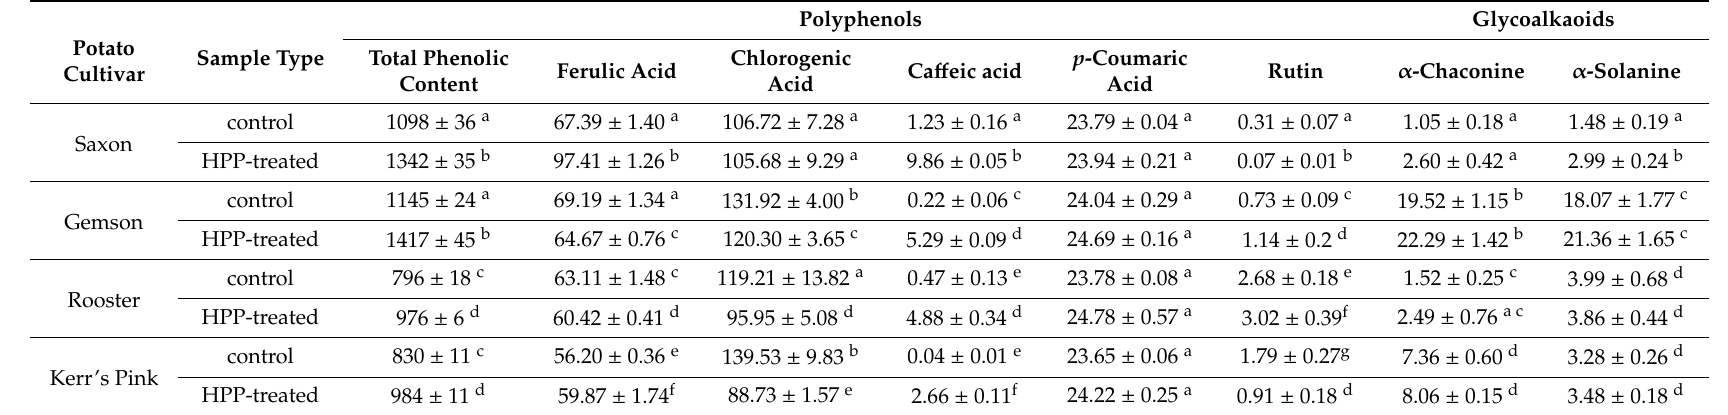
Table 2. Total phenolic content ( µ g / g dry weight), and phytochemical content ( µ g / g dry weight) in the untreated (control) and HPP treated potato cultivars.